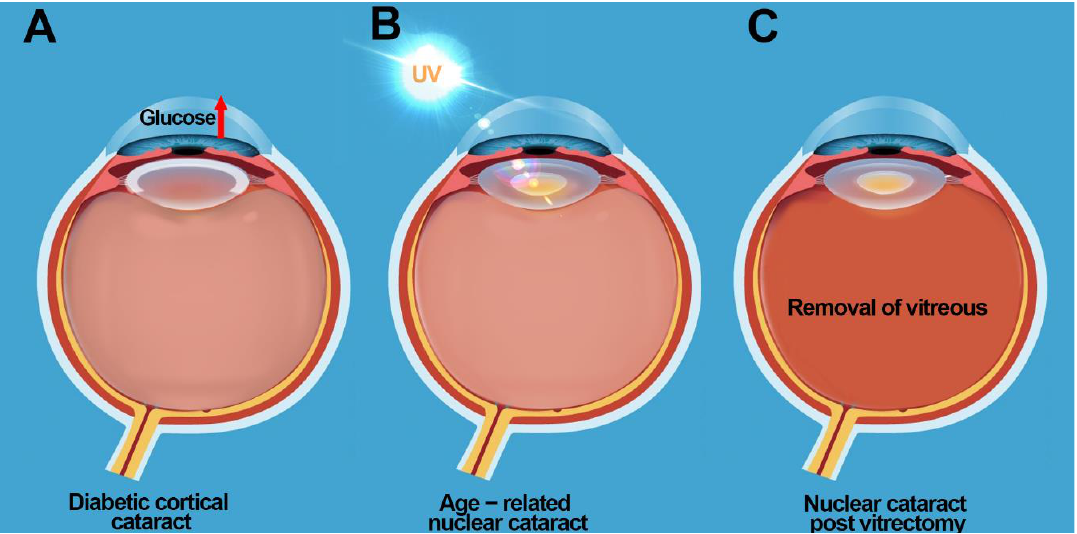
Figure 2. Schematic of the eye showing the development of ( A ) diabetic cortical cataract due to elevated levels of glucose, ( B ) age-related nuclear cataract due to UV exposure, and ( C ) nuclear cataract post vitrectomy due to depletion of vitamin C and elevated PO 2 levels.